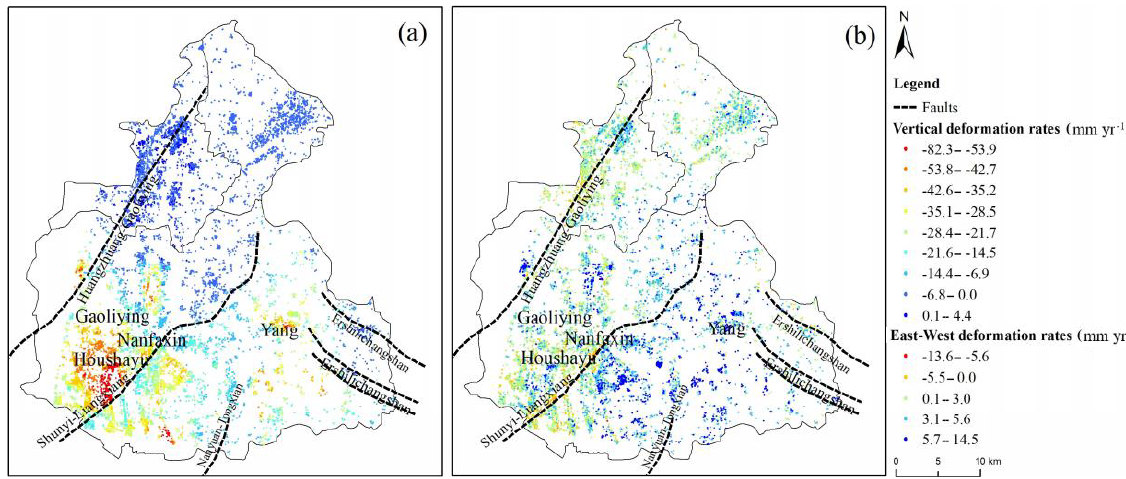
Figure 3. (a) the vertical deformation rates and (b) the East-West deformation rates (June 2015 to December 2017).